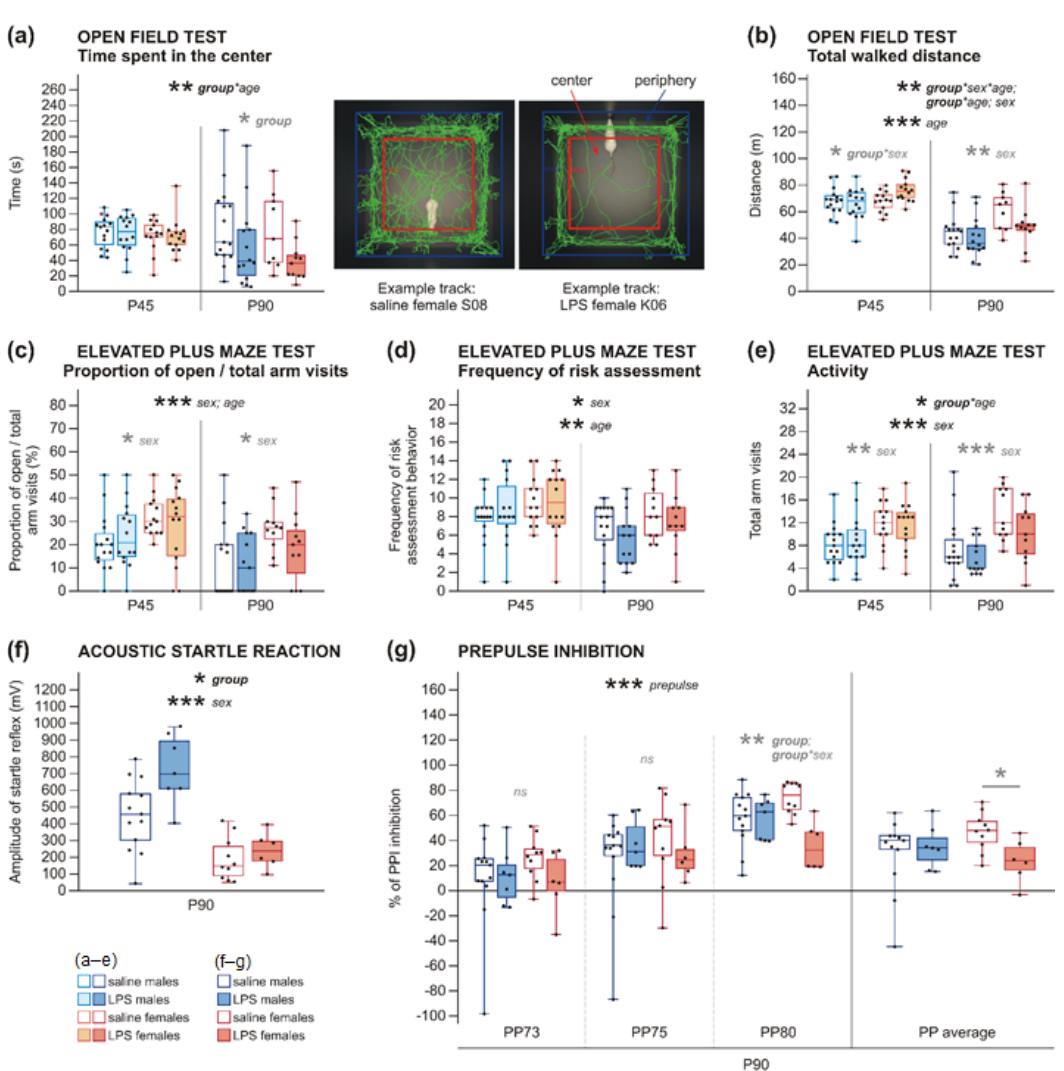
Figure 6. Non-social behavior in P45 and P90 rats. ( a ) In the open field test (OF), the rats of both sexes prenatally exposed to LPS spent less time in the center of the arena in comparison to saline-exposed rats, as revealed by 3wANOVA-RM with simple effects and 2wANOVA, but only in adulthood, not in adolescence. ( b ) Total walked distance measured in OF was changed differently at P45 and P90 by prenatal exposure to LPS. In adolescence, LPS males did not differ from control males; in contrast, LPS females walked a longer distance than control females. In adulthood, both LPS males and females tended to walk a shorter distance than the control animals. In addition, males showed decreased locomotor activity compared to females as well as adults compared to adolescents. The results were evaluated by 3wANOVA-RM and 2wANOVA. ( c , d ) In the elevated plus maze test (EPM), the proportion of open arm visits to total arm visits ( c ) and frequency of risk assessment behavior ( d ) were not significantly affected by LPS administration to pregnant dams. However, sex differences were found by 3wANOVA-RM: males had lower open arm visits ratio and also lower risk assessment behavior compared to females. Similar result was found in adult rats in comparison to adolescents. ( e ) Activity in EPM was not changed by LPS experience at P45, but it slightly decreased at P90 in LPS males as well as females, as shown by 3wANOVA-RM and as a trend by 2wANOVA. In males, the activity was also decreased in comparison to females. ( f ) LPS-exposed animals showed a higher startle response to strong acoustic stimuli (120 dB), compared to controls, according to 2wANOVA. The difference was more manifested in males. Moreover, the analysis revealed a higher startle response in males compared to females. ( g ) Prepulse inhibition deficit was found by 2wANOVA and t -tests in LPS females, especially after strong stimulus with 80-dB prepulse (PP), but not in LPS males. The boxplots show median, first and third quartile, and minimum and maximum values; the dots show individual values. * p < 0.05, ** p < 0.01, *** p <